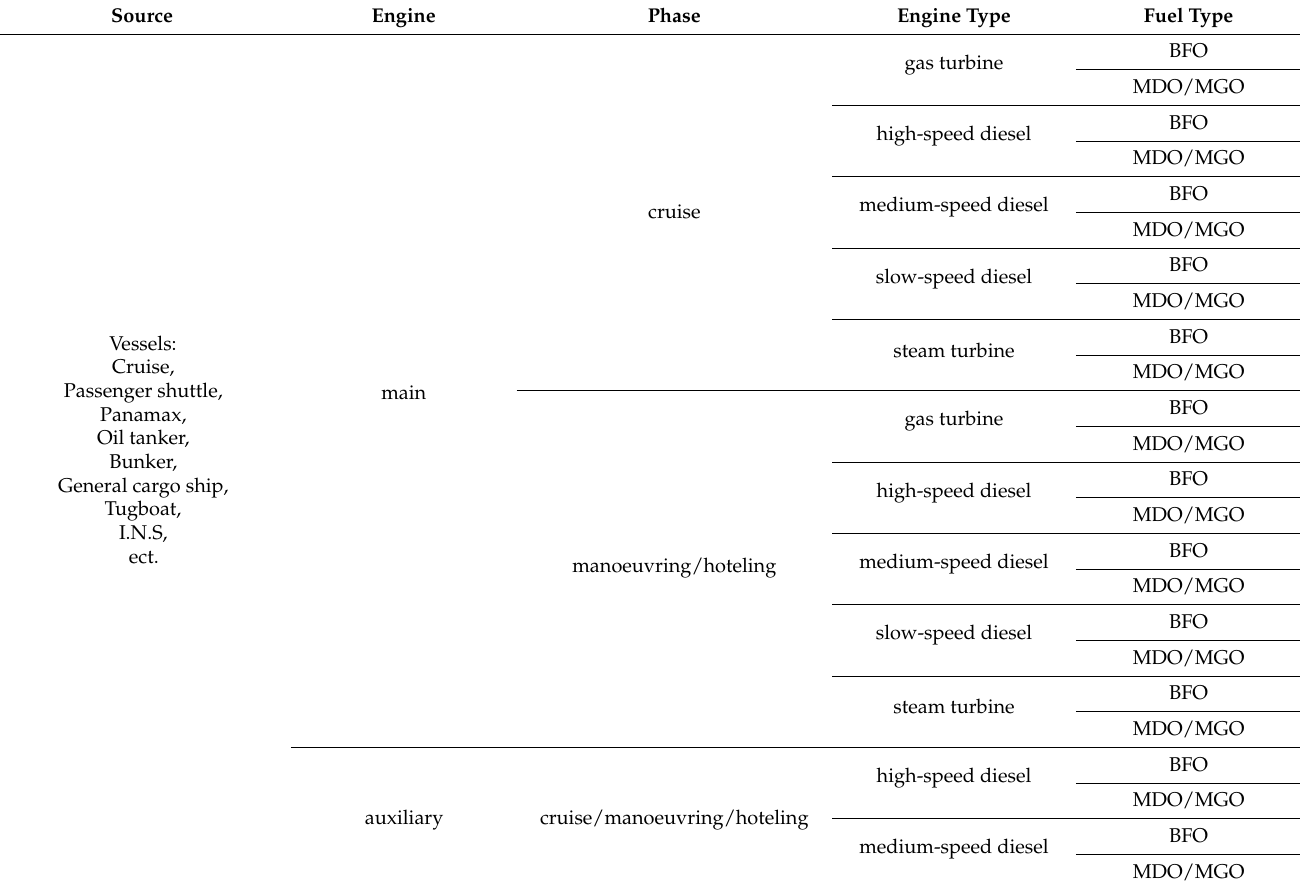
Table A1. Marine emission sources and major mobile sources in HAIFA